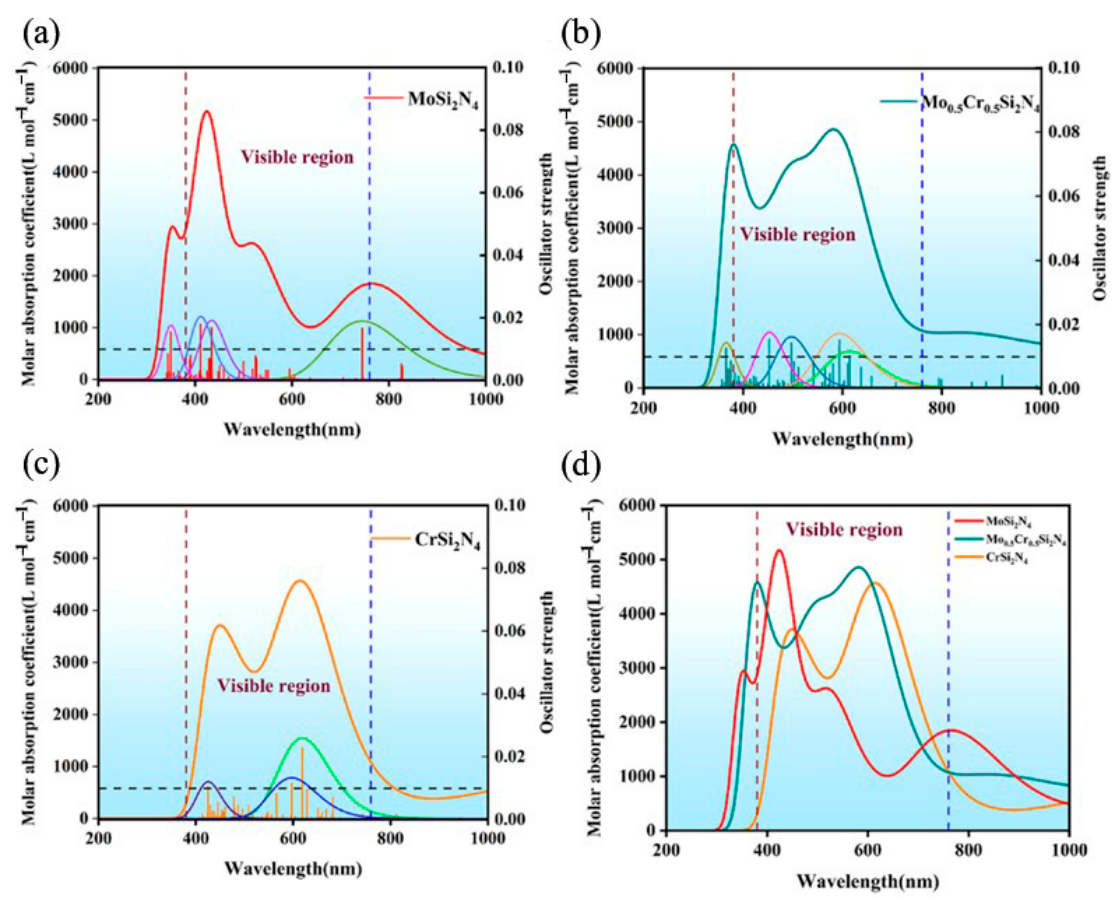
Figure 5. ( a ) The ultraviolet (UV)visible spectra of MoSi 2 N 4 (red); ( b ) The ultraviolet (UV)visible spectra of Mo 0.5 Cr 0.5 Si 2 N 4 (dark cyan); ( c ) The ultraviolet (UV)visible spectra of CrSi 2 N 4 (orange); The peaks of other colors represent various excited states whose contribution intensity is greater than 0.01. ( d ) The ultraviolet (UV)–visible spectra of MoSi 2 N 4 (red), Mo 0.5 Cr 0.5 Si 2 N 4 (dark cyan) and CrSi 2 N 4 (orange). In comparison, strong absorption bands of CrSi 2 N 4 are located at 450.3 nm (blue) in the blue range and 614.8 nm (red) in the red range (Figure 5c). The peak at 614.8 nm is mainly from the degenerate S0 → S37 with an oscillator strength of 0.023, the only oscillator with strength above 0.02. The ultraviolet (UV)–visible spectra of the three materials are plotted in Figure 5d. Surprisingly, the substitution of Cr atoms in the monolayer MoSi 2 N 4 can slightly reduce the absorption peak heights of the UV and visible absorption spectra, leading to a redshift in the spectra. The major reason for this phenomenon may be that the monolayer CrSi 2 N 4 is more likely to absorb low-energy photons (energy). More interestingly, after the Mo atoms in the monolayer MoSi 2 N 4 are half-replaced by Cr atoms, the ultraviolet (UV)–visible absorption spectra split from the previous single peak at 424.5 nm to double peaks near 400 nm and 600 nm, and the positions of these two peaks do not overlap with the monolayer CrSi 2 N 4 as well as the monolayer MoSi 2 N 4 . This indicates that monolayer Mo 0.5 Cr 0.5 Si 2 N 4 not only has some properties of monolayer MoSi 2 N 4 and monolayer CrSi 2 N 4 but also has the coupling effect between Cr atoms and Mo atoms. Most importantly, this proves that the light absorption properties of such materials can be